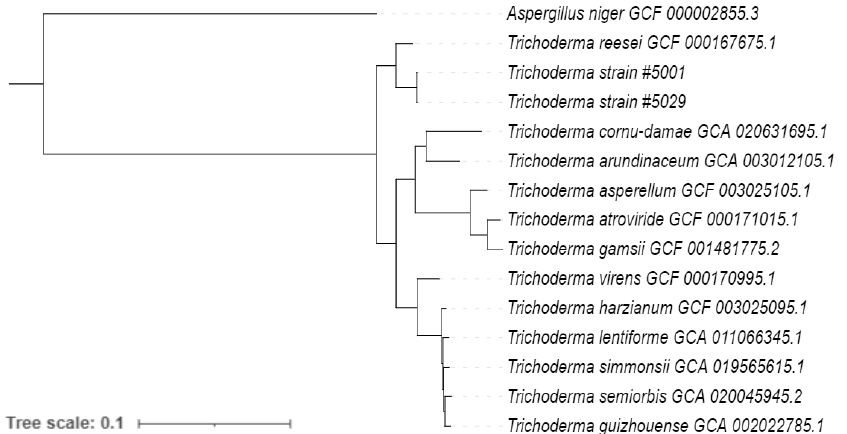
Figure 1. Maximum-likelihood phylogenetic tree of 15 Trichoderma strains constructed using 3059 single-copy genes present in all the analysed genomes, using the maximum-likelihood method and with A. niger as the outgroup.